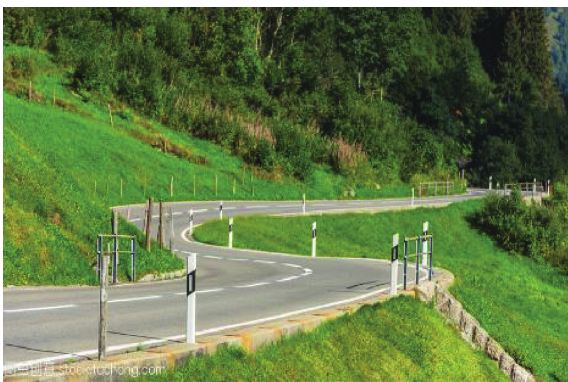
Figure 1: A highway on a mountainside (copy from Baidu).